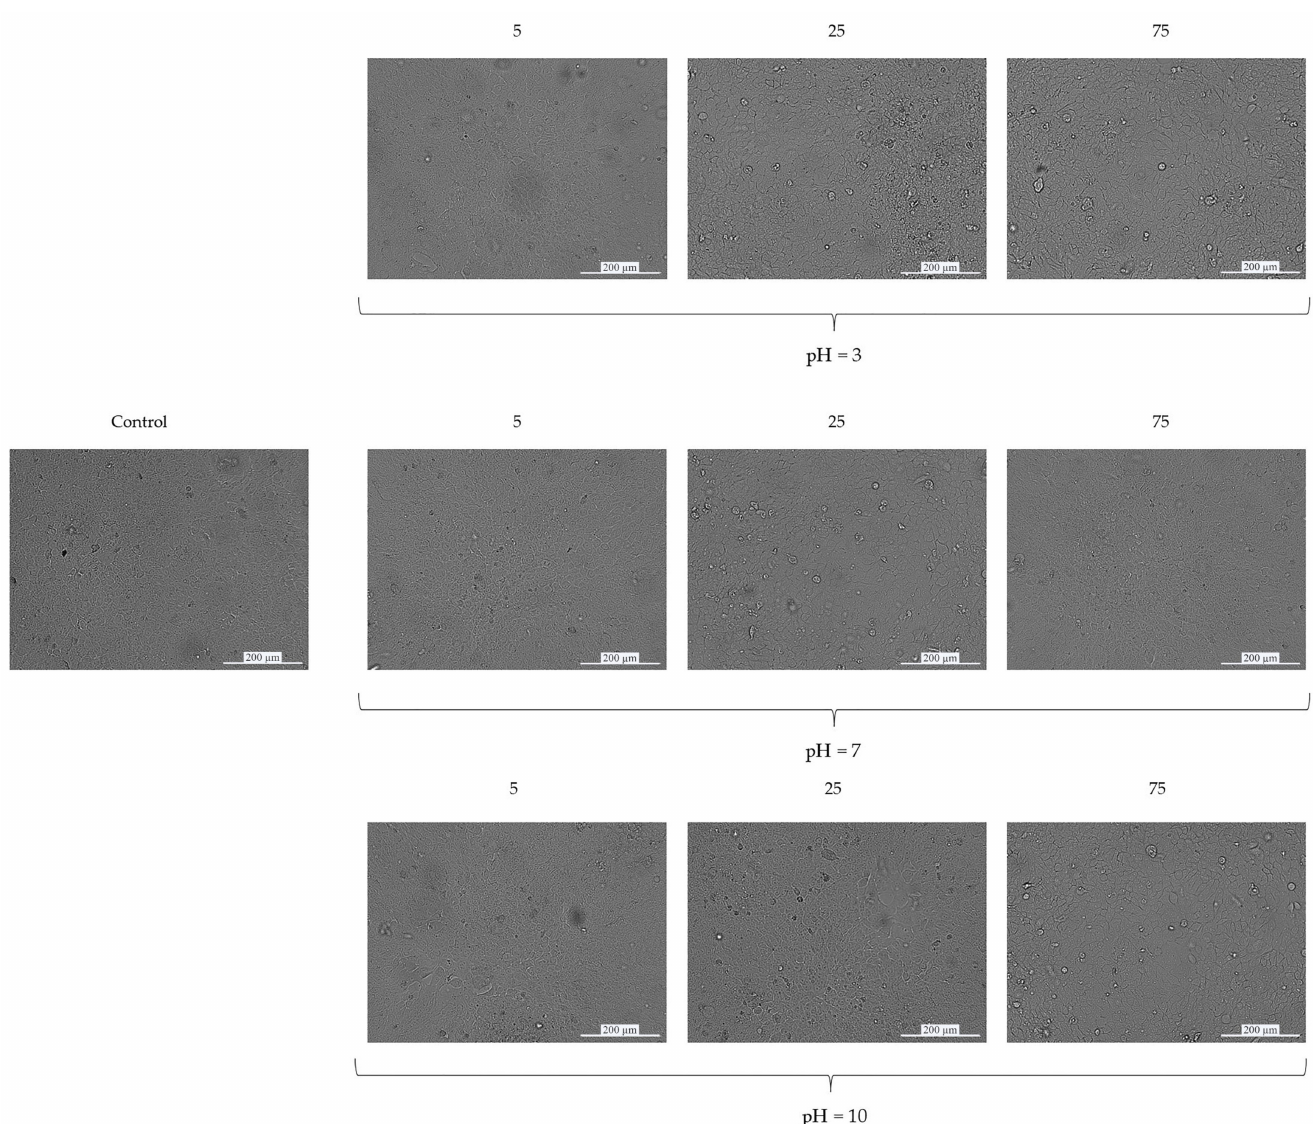
Figure 3. Morphological and shape changes produced by P1 (5, 25, and 75 µ g/mL) in Detroit-562 after 72 h of treatment. The morphology of the cells was not altered by P1, with the number, confluence, and shape of cells treated with P1 remaining the same as those observed in control cells. The scale bars indicate 200 µ